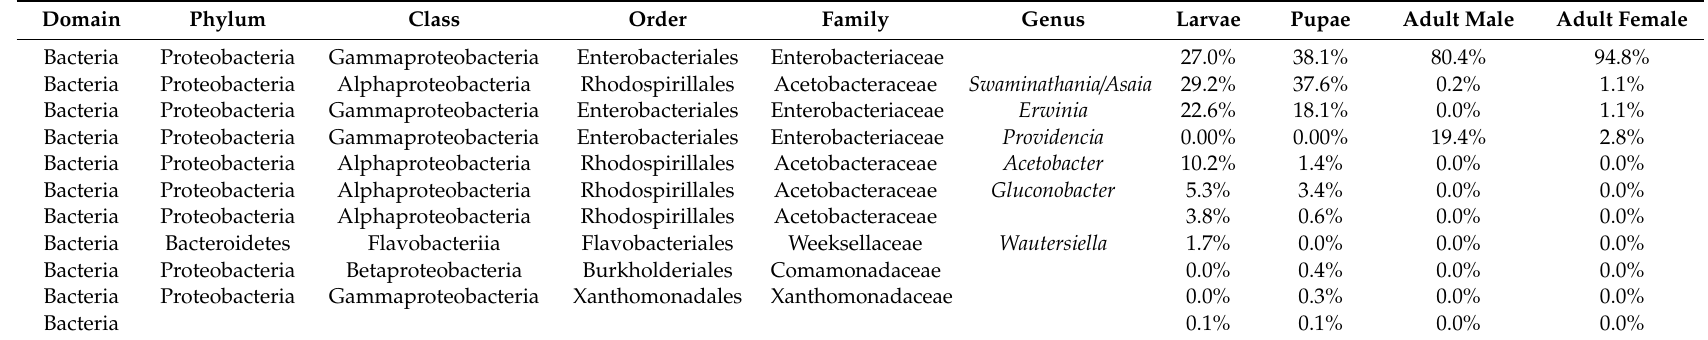
Table 1. Taxonomic identification of the of the 11 most abundant bacterial taxa in the Qfly across all developmental stages (% based on genus level).